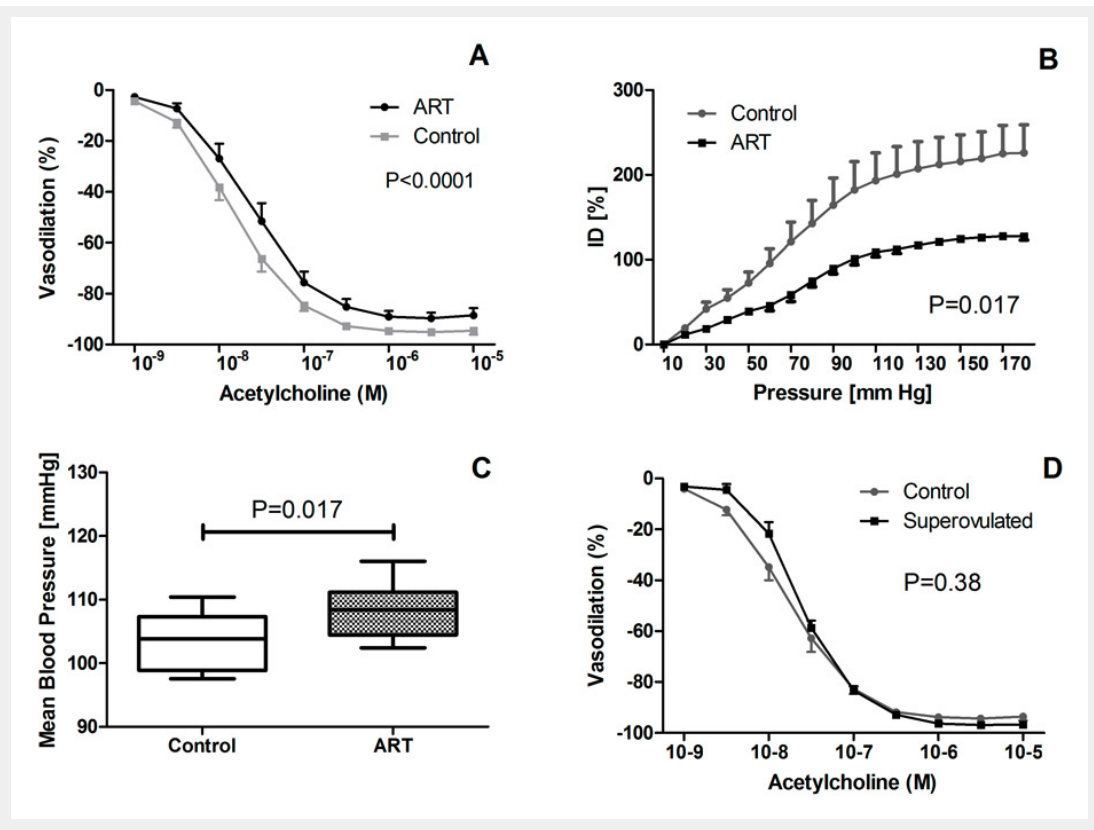
Figure 4 Vascular function and arterial blood pressure in mice generated by ART and control mice. Panel A shows acetylcholine-induced mesenteric artery vasodilation, Panel B the carotid artery pressure-diameter relationship, a proxy of vascular stiffness, Panel C shows mean arterial blood pressure obtained by telemetry. Panel D shows acetylcholine-induced mesenteric artery vasodilation in mice conceived during stimulation of the ovulation in the mother and control